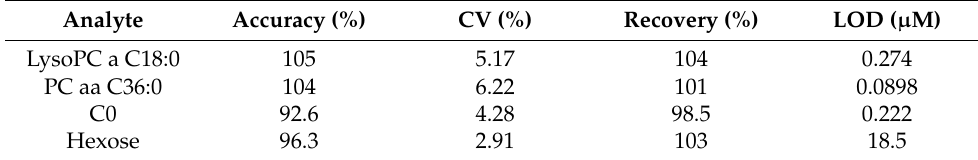
Table 5. Validation Performance of Representative Analytes Analyzed via DFI-MS/MS.